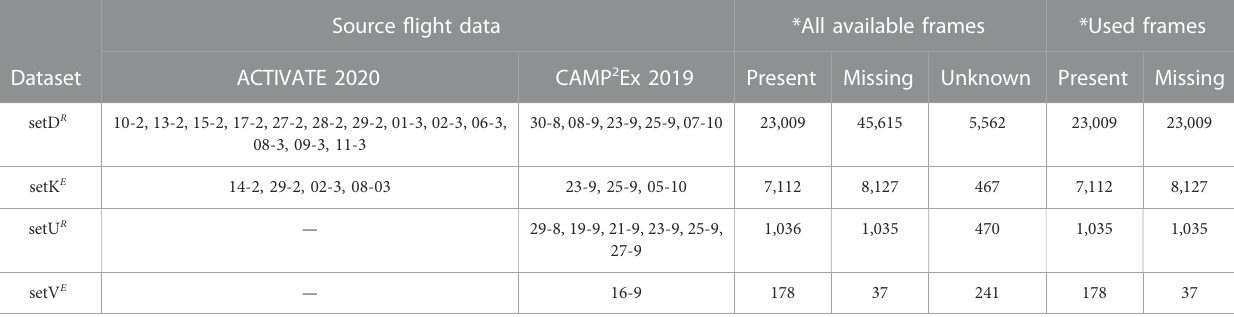
TABLE 2 Dataset information is used to train and test the forward CDNN and zenith CDNN. The sections denoted with a * represent the number of labeled frames whereagiventagispresent.For setD and setK ,thisisforthe cirrus_clouds tag,whichisassociatedwiththeforwardCDNN.For setU and setV ,thisisforthe cas tag, which is associated with the zenith CDNN. The Used Frames section does not contain an Unknown column since all frames that are not explicitly known are dropped from the training and testing datasets. Additionally, the Used Frames section speci fi es the number of frames that are used during training via the min samplemodeandtesting via the max samplemode.Thedatasetshaveasuperscriptofeither R tolabeltrainingdataor E tolabeltestingdata.Fortheresearch fl ightdates,whiletheremaybeanoverlapinthedaysbetweentrainingandtestingsets,thereiszerosharedfootage.Thereasonforthisisthattherearemultiple videos taken on certain research fl ight